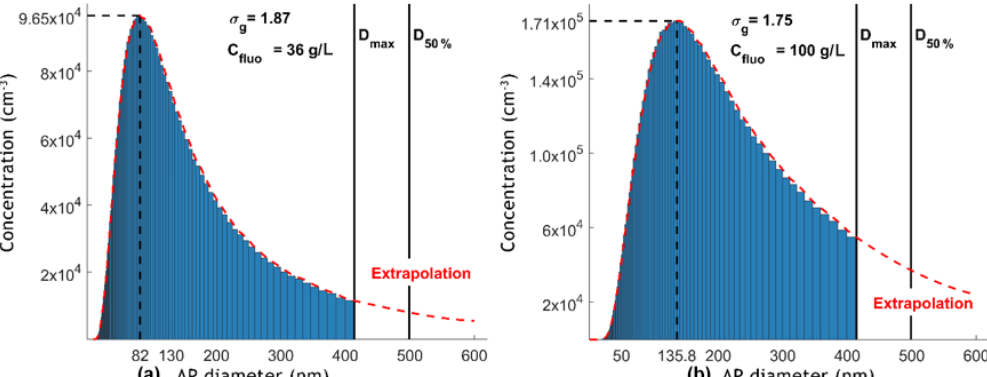
Figure 7. Two typical AP size distributions obtained with a SMPS at the atomiser’s outlet. The concentration of the sodium fluorescein salt solution is 36gL − 1 (a) and 100gL − 1 (b) . D max and D 50% are respectively the maximum diameter selected by the DMA and the cut-off diameter of the impactor at the DMA’s inlet, at a given AP flow rate (0.6Lmin − 1 ).